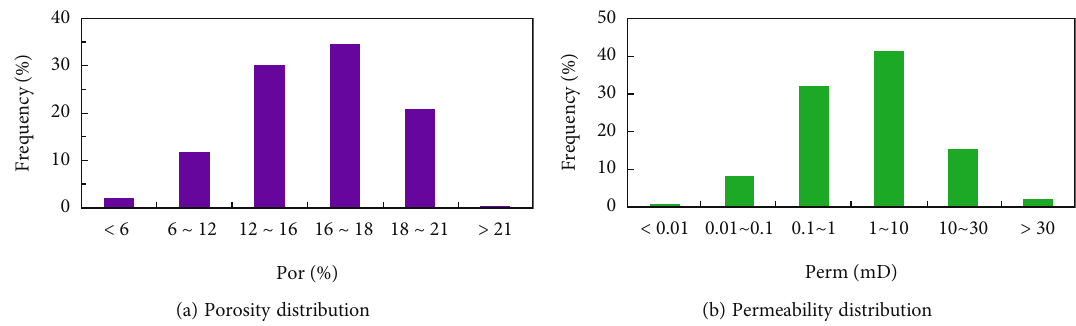
Figure 2: Porosity and permeability distribution histograms in Chang 8